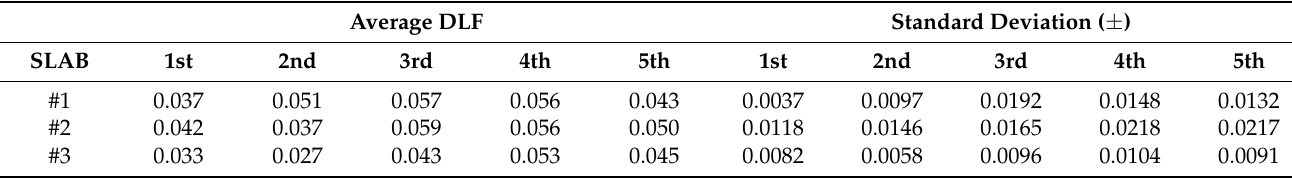
Table 7. Average trend and standard deviation of DLF values of normal walk ( f p = 1.5 Hz), as obtained from experimental records for lateral force component on different substructures (with 8 walking records for SLAB#1, 10 for #2, and 9 for #3 and a single adult pedestrian volunteer). Average DLF Standard Deviation ( ±